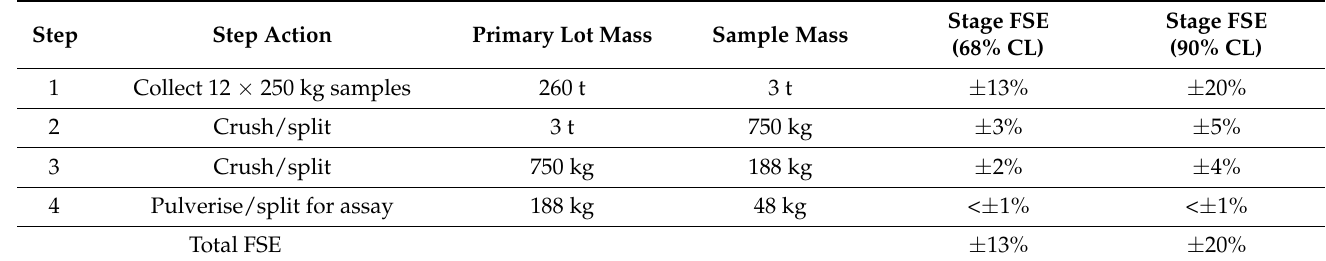
Table 5. Potential sample preparation and assay protocol based on reducing a 250 kg sample to 2.5 kg for assay. The FSE values are rounded to the nearest whole percent. The FSE calculation is based on a grade of 10 g/t Au, liberation diameter of 1 mm, and nominal material size of 5 cm (assuming dominant concentration of gold in the − 5 cm fraction).